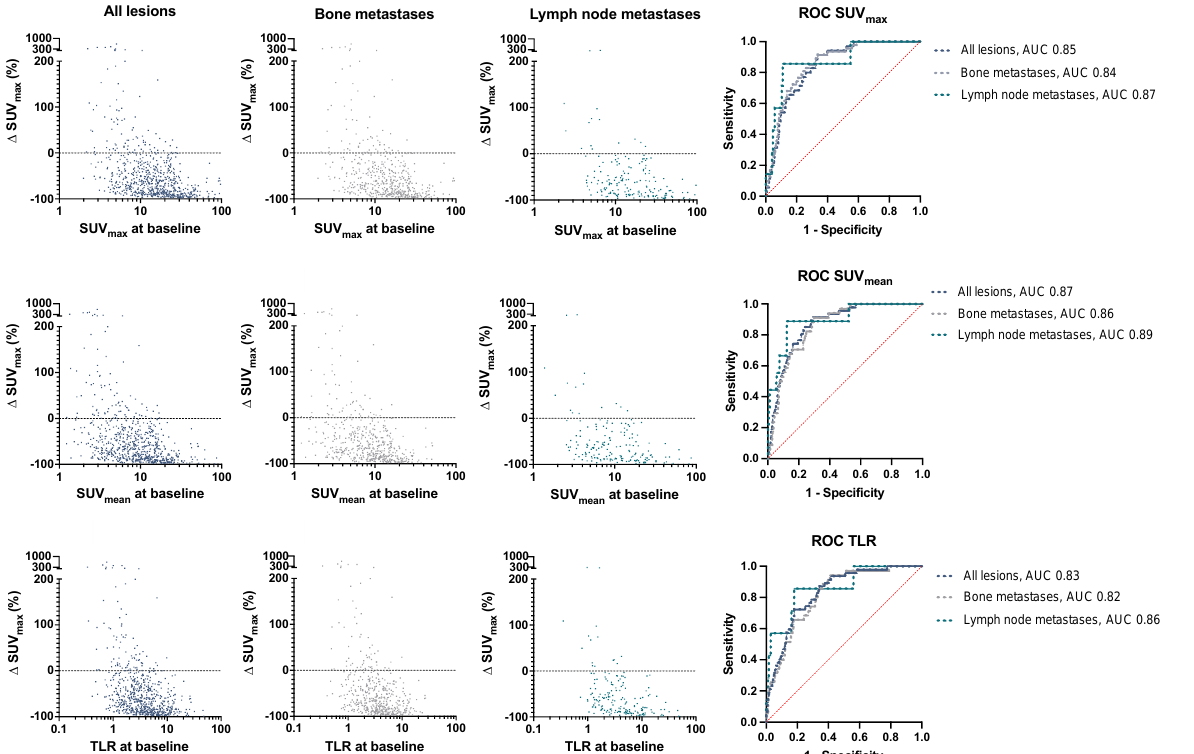
Figure 2. Change (%) in SUV max over baseline values for SUV max , SUV mean , and TLR in all lesions and in bone/lymph node metastases. Receiver operating characteristic (ROC) curve for lesion progres- sion depending on baseline PET values. SUV: standardized uptake value, TLR: tumor-to-liver ratio, AUC: area under the curve.